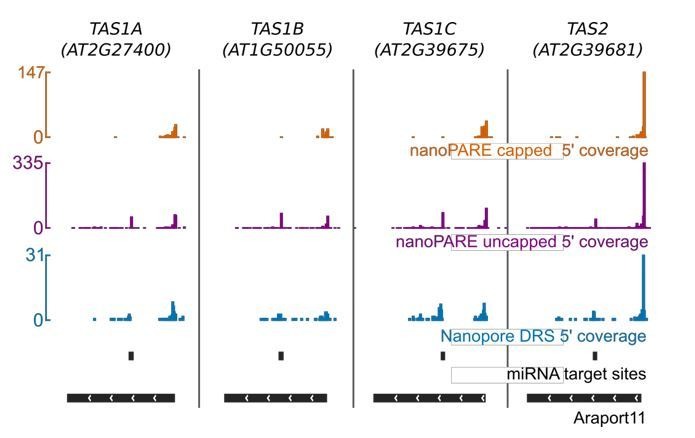
Nanopore DRS captures downstream products of miRNA cleavage at transcripts encoded by TAS genes.Orange, 5’ coverage from capped nanoPARE reads; purple, 5’ coverage from uncapped nanoPARE reads; blue, nanopore DRS 5’ coverage; black miRNA target site alignment; black, Araport11 annotation.